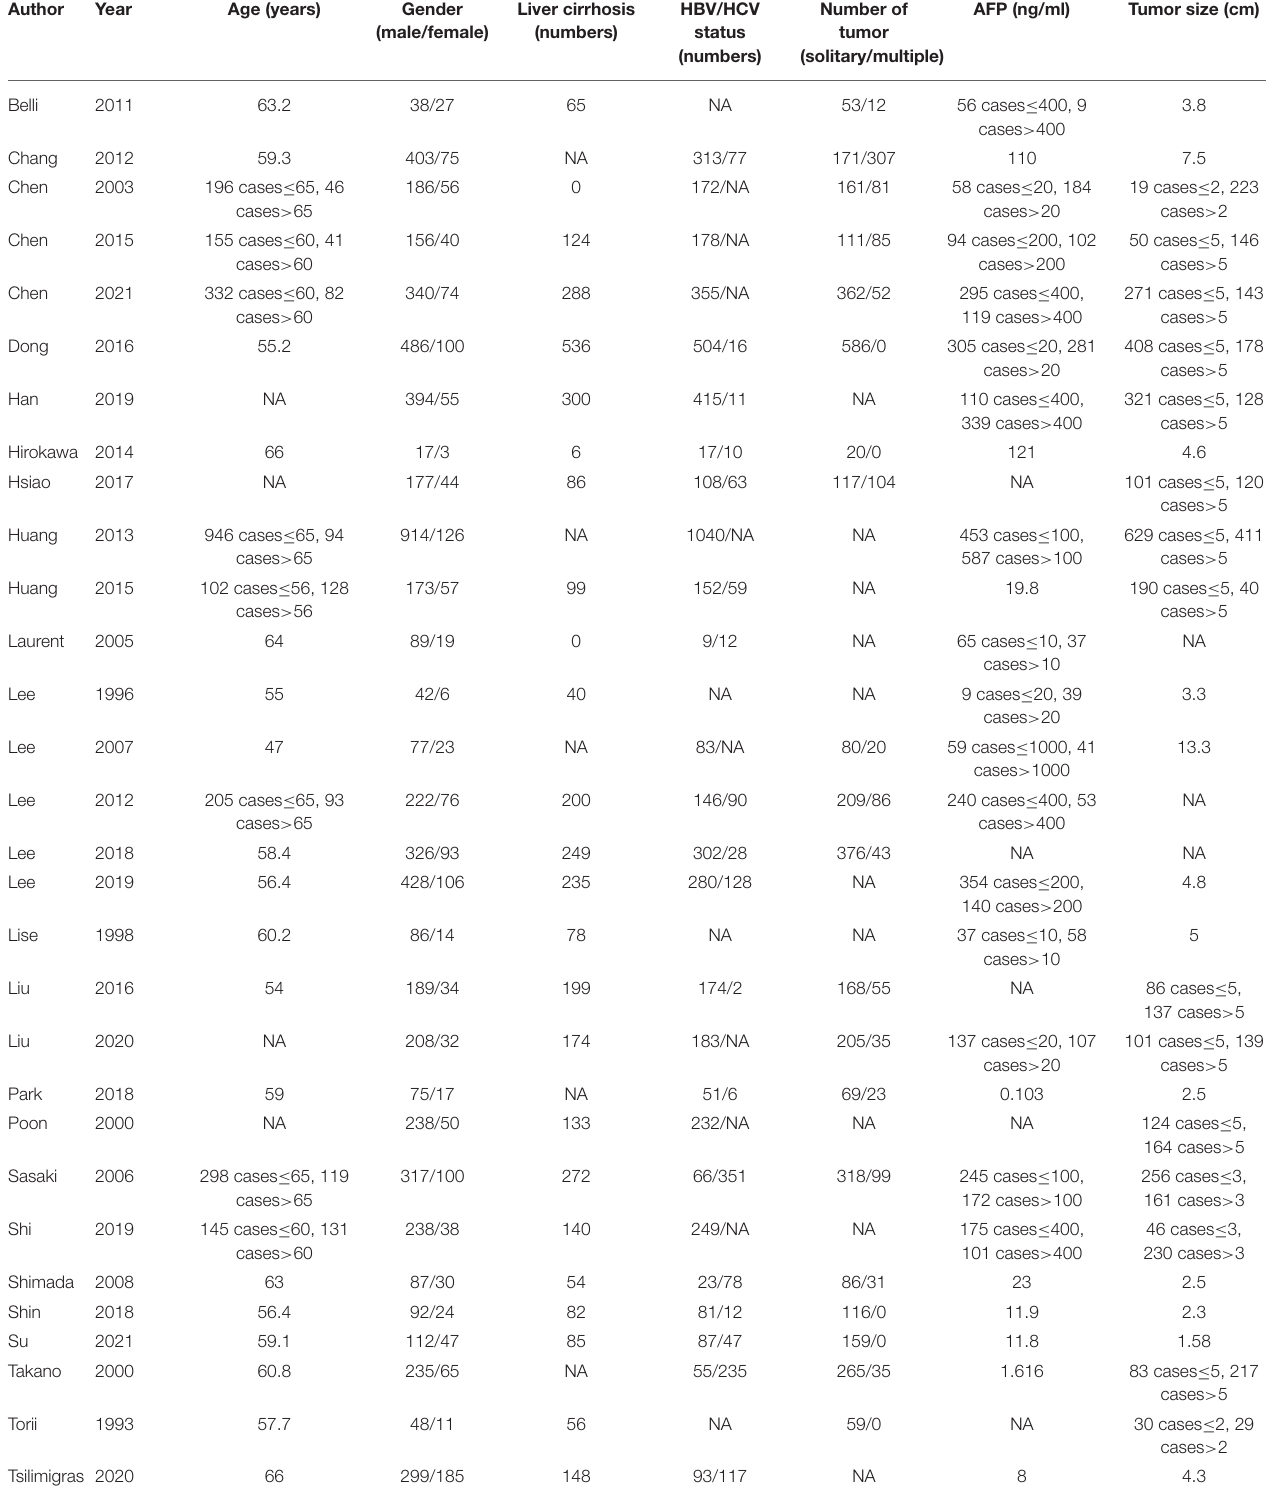
TABLE 1-2 | Characteristics of all the studies included in the